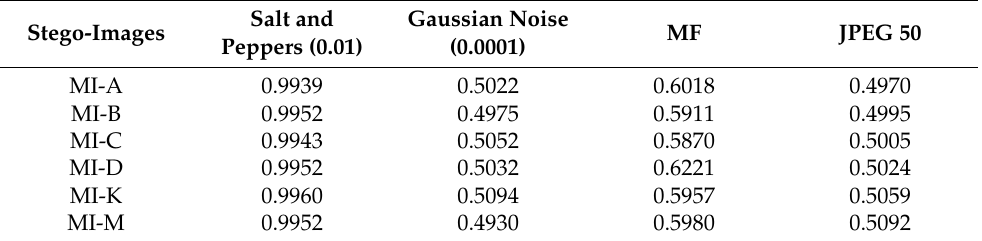
Table 5. NCC for various attacks.